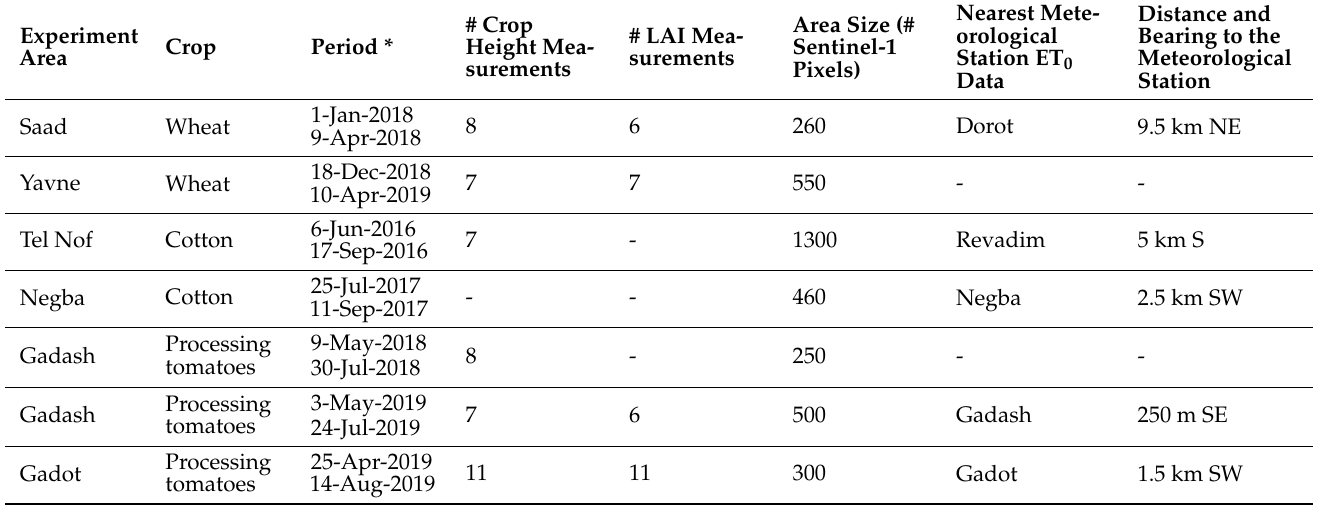
Table 2. Summary of seven field experiments conducted at six locations in